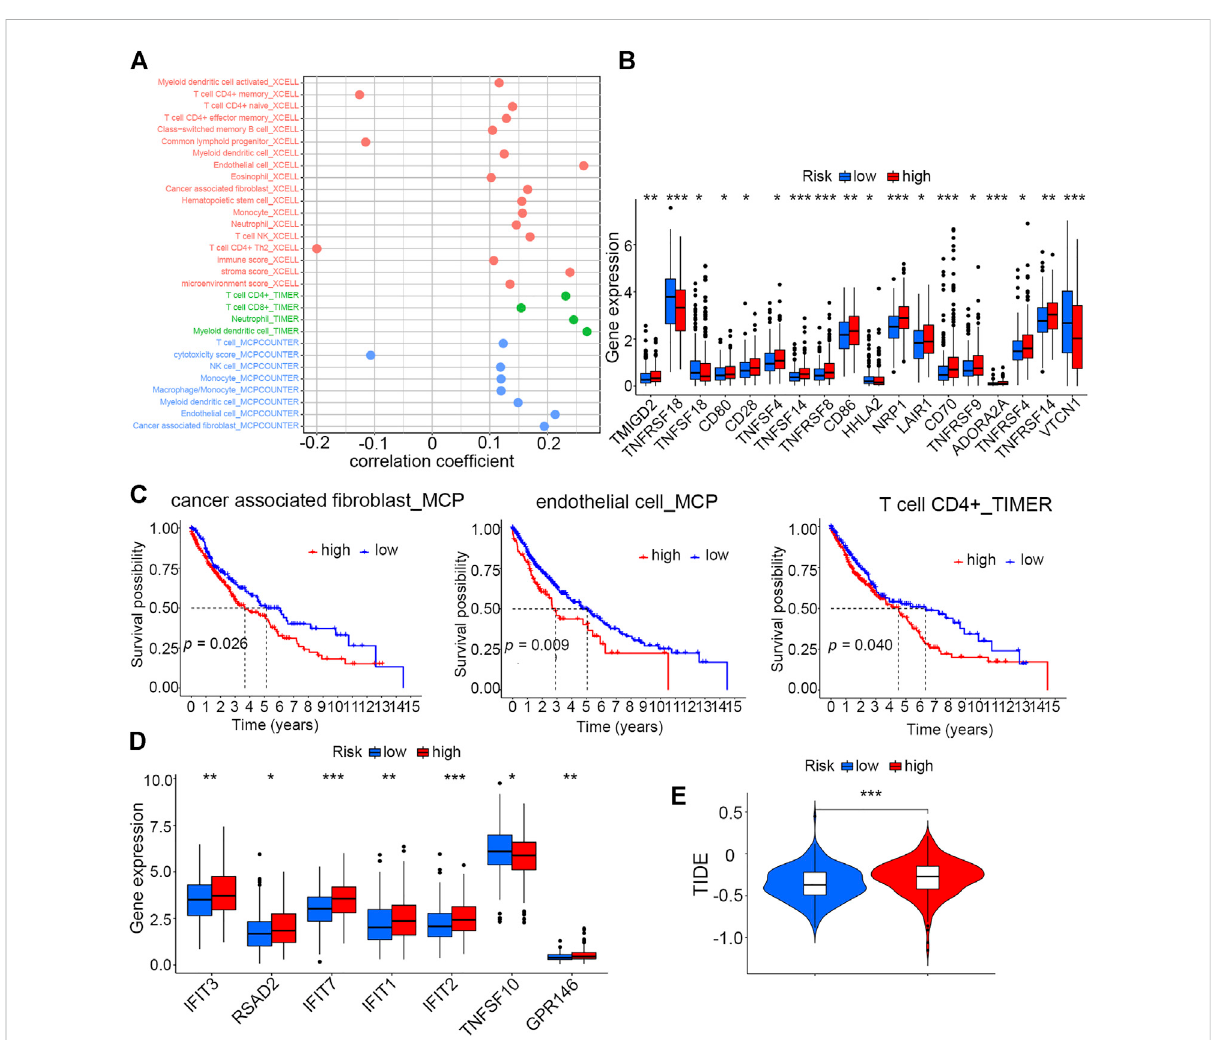
FIGURE 6 Correlation analysis of risk scores with the TME and immunotherapy (A) Correlation analysis of the risk score with in fi ltration levels of immune cells by three different algorithms. (B) Differences in expression levels of immune checkpoint molecules between high- and low-risk groups (* p < 0.05, ** p < 0.01, and *** p < 0.001). (C) Kaplan – Meier analysis of cancer-associated fi broblasts, endothelial cells (MCP), and CD4 + T cells (TIMER) between high- and low-risk groups. (D) Differences in expression levels of seven IFN-related genes between high- and low-risk groups (* p < 0.05,** p < 0.01,and*** p < 0.001). (E) Tumorimmunedysfunctionandexclusion(TIDE)analysistopredictthesensitivityofpatientsinhigh-andlow- risk groups to immunotherapy (*** p <